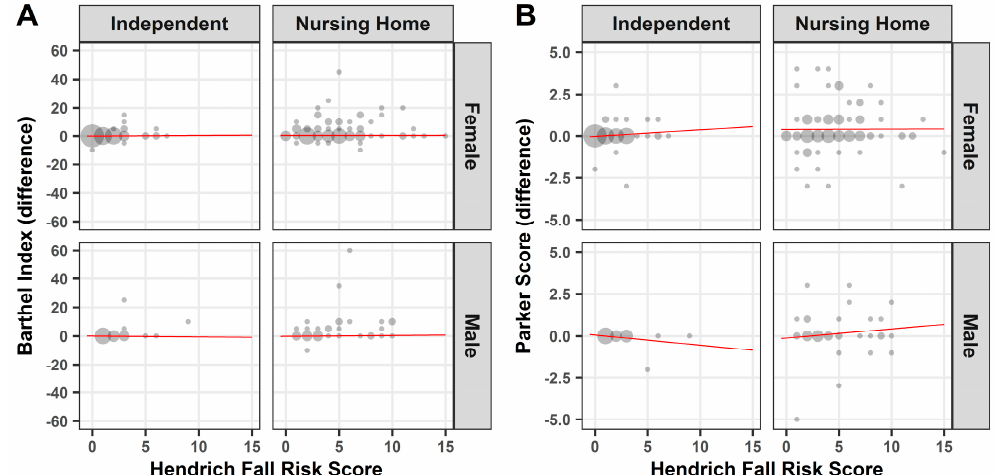
Figure 5. Hendrich Fall Risk Model—Correlation: Point plot illustration of Barthel Index ( A ) or Parker Mobility Score ( B ) against the Hendrich Fall Risk Score. Red line: linear regression.